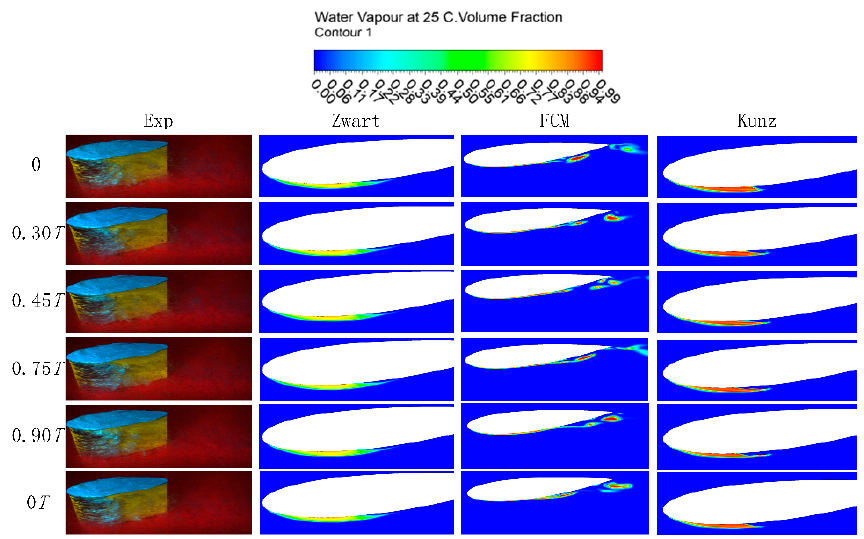
Figure 6. Time evolution of sheet cavitation for numerical results and experimental pictures ( σ = 1.075, α = 60°).